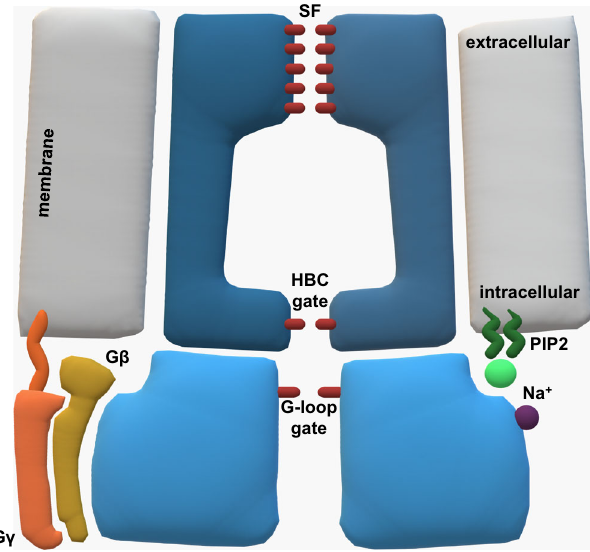
Fig. 1 The structure of the GIRK2 channel and its regulators. Two of the four subunits of the channel as well as channel modulators are